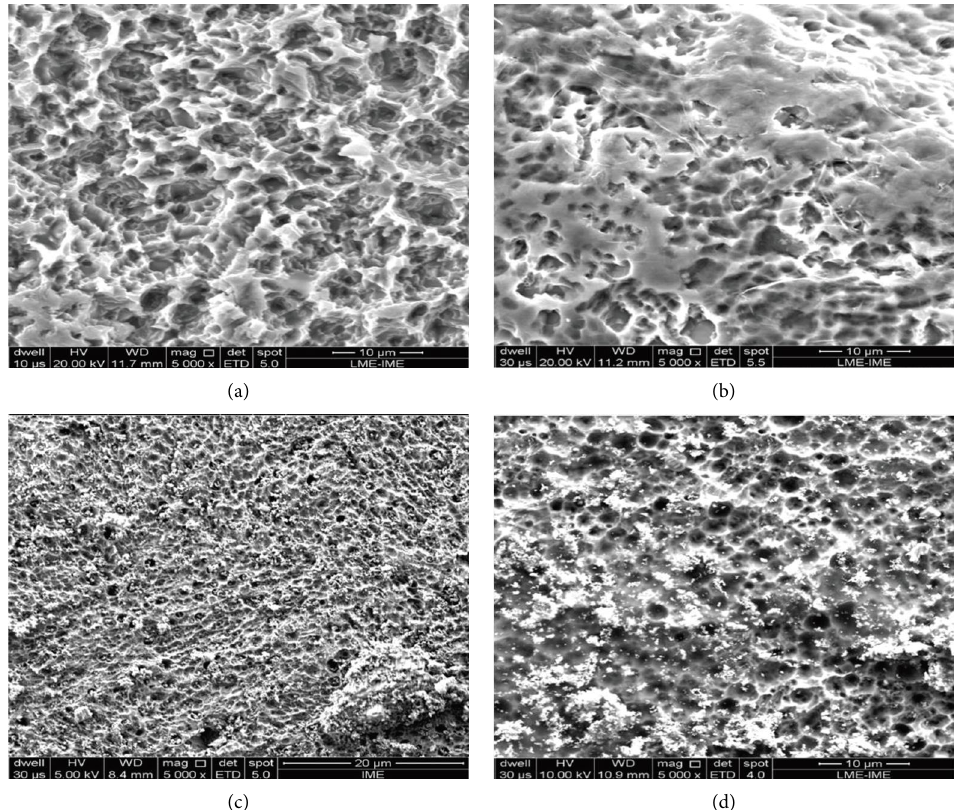
Figure 3: Ti surface morphology before and after graphene coating at low magnifcation. (a) cp Ti before coating. (b) cp Ti-GO. (c) cp Ti-NB. (d) cp